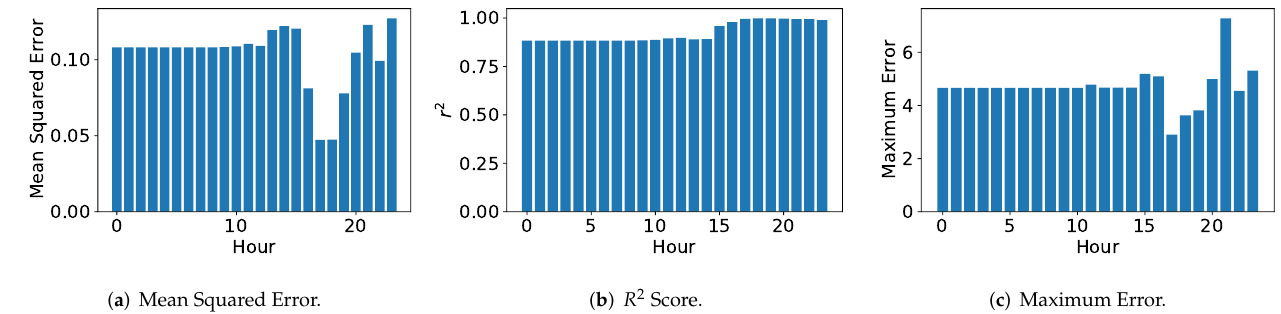
( c ) Maximum Error.